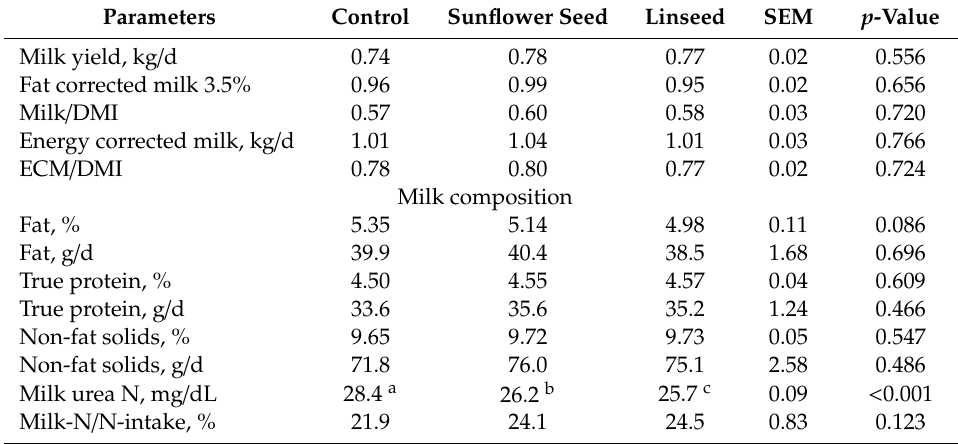
Table 5. Milk composition from dairy goats fed control (Megalac-R ® ), sunflower (SF) and linseed (LS) treatments (n = 9 per